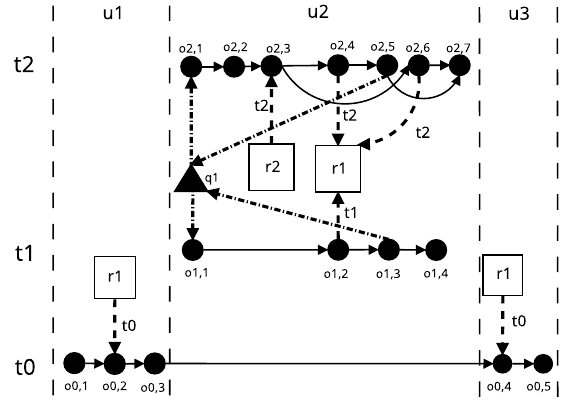
Figure 4. DL1 application operation